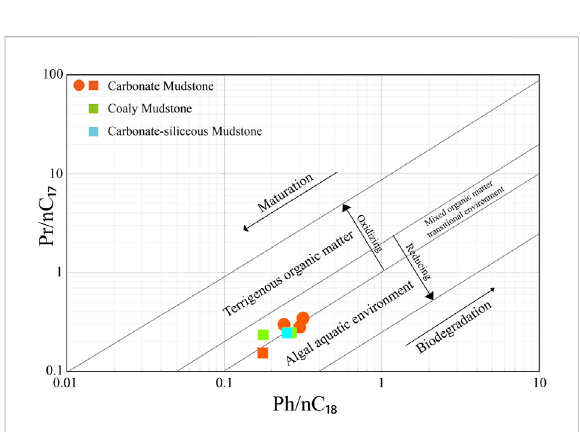
FIGURE 9 Plot of pristane/n-C17 (Pr ∕ n-C17) versus phytane/n-C18 (Ph/ n-C18) for the samples from the Huai Hin Lat Formation. The red rectangle, green rectangle, and blue rectangle represent the samples from location A, while the red dot denotes the samples from location